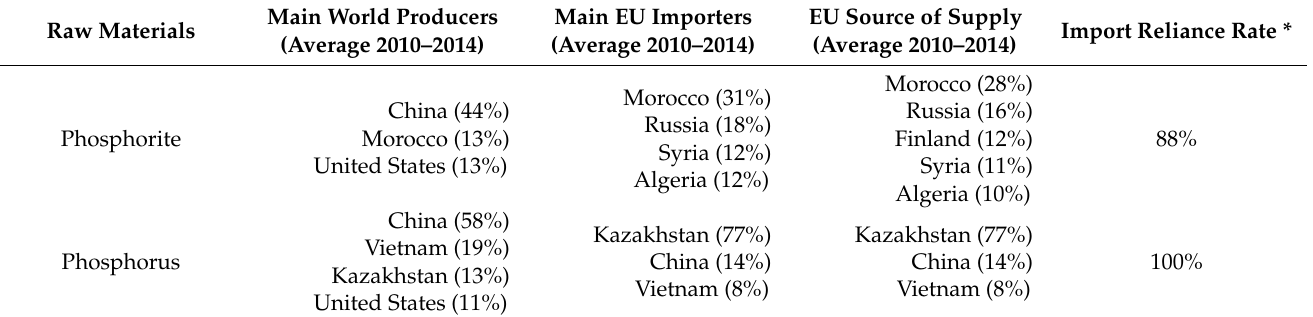
Table 1. Major world producers and supply sources of phosphorus and phosphorite, both consid- ered essential raw materials. Data from European Commission [17]. Percentages refer to major producers/importers